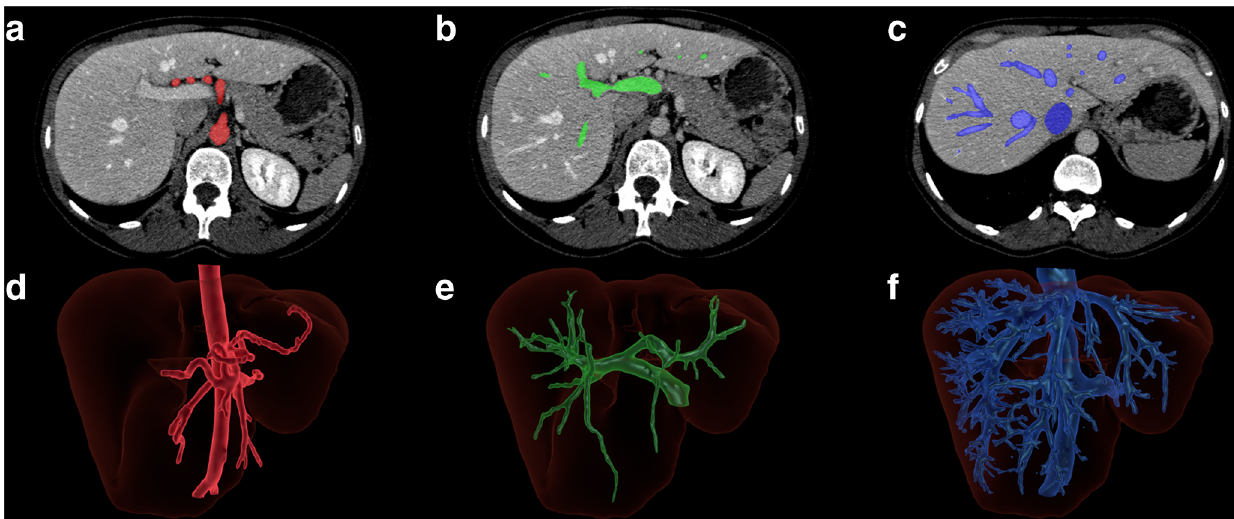
liver showing the correspondingsegmented d arterial, e portalvenousand f hepatic venous structures